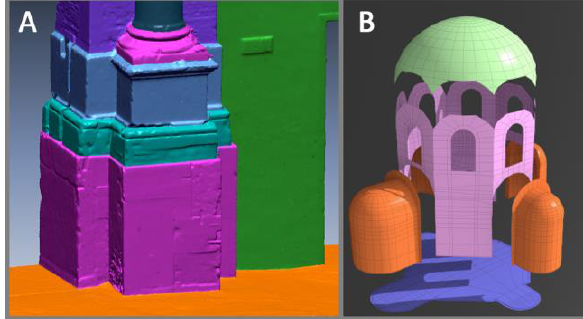
Figure 5. Examples of semantic partition on a High-Poly mesh (A) and on a Low-Poly mesh from retopology.